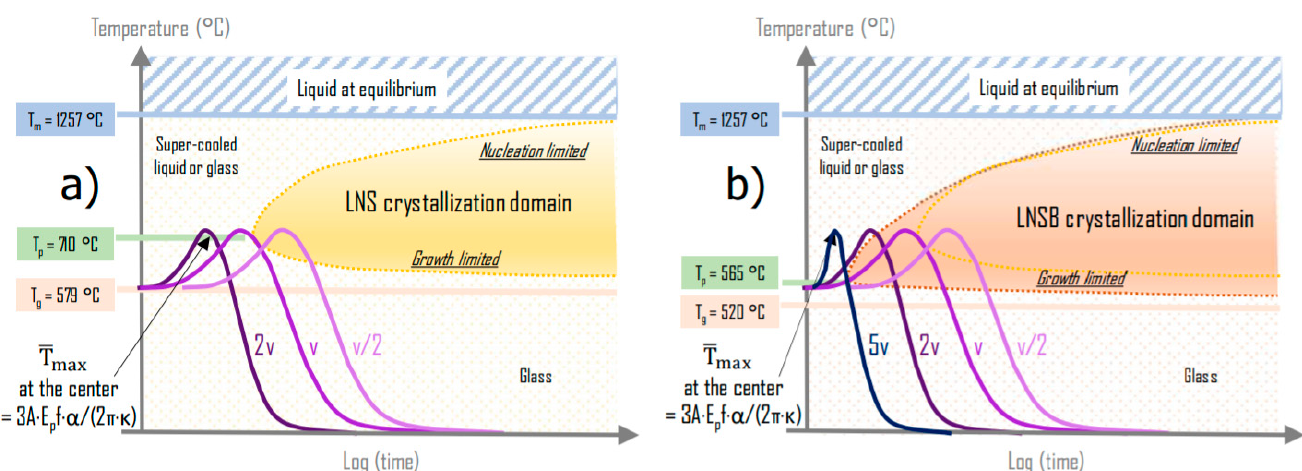
Figure 9. Scheme of the effect of the scanning speed on the crystallization for the two glasses (( a ) LNS and ( b ) LNSB) investigated in this paper. (1) The crystallization domains are sketched based on the following rules: they are limited by the T g on bottom side and T m on top side; the nucleation top side is not changed because it only depends on the thermodynamics driving force of the nuclei that we assume the same for both glasses [34]. However, the growth rate is increasing with the strong decrease of the viscosity. These changes lead to a strong decrease of the incubation time. (2) The maximum average temperature is defined by pulse energy and the repetition rate (E p ∙ f). It does not change on the scanning speed (v) and very little on the chemical composition. Whatever the speed, the coincidence of the time scales between TTT and treatment curve is fixed when the treatment curves cross T g , considered to be the starting time for crystallization (what happens below T g is expected to have insignificant effect on the crystallization kinetics).